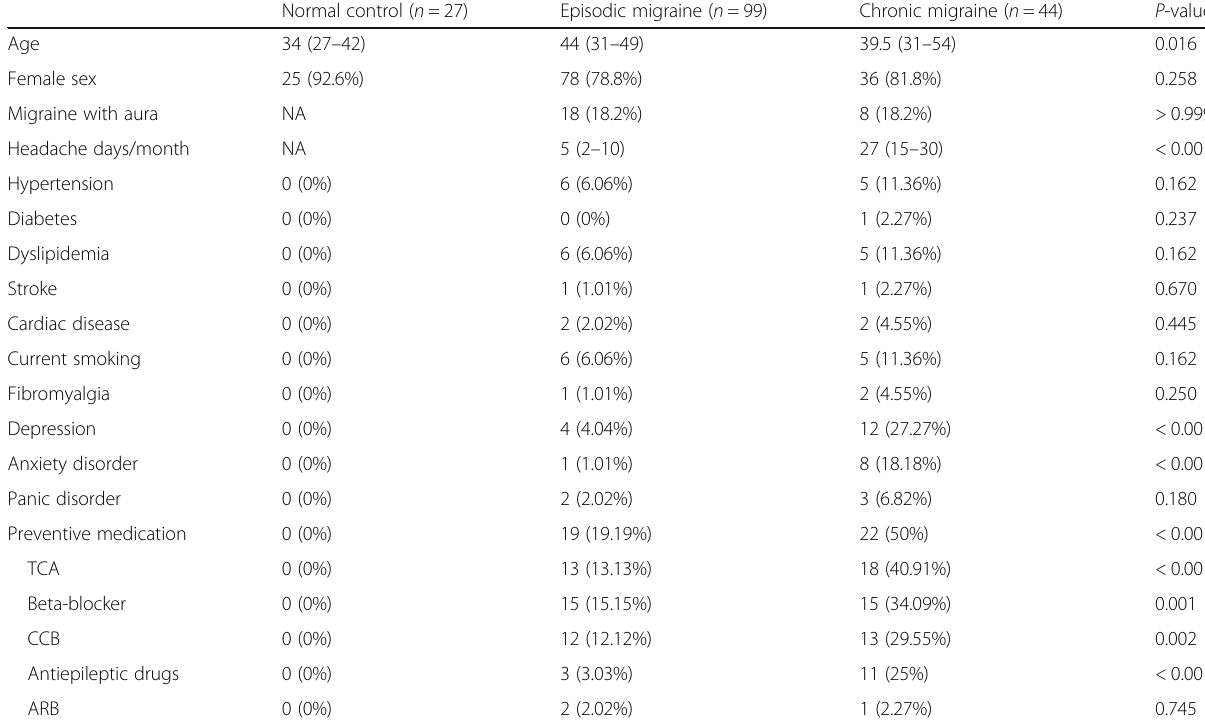
Table 1 Characteristics of study subjects